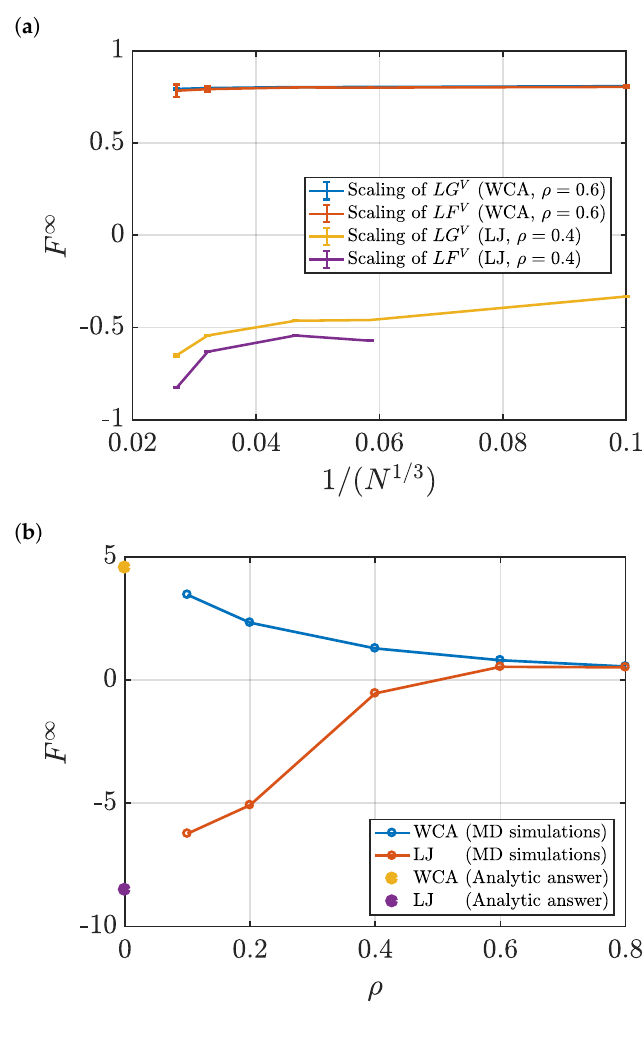
Figure 14. ( a ) Surface term in the thermodynamic limit F ∞ as a function of the size of the system for the WCA fluid at ρ = 0.6, and the LJ fluid at ρ = 0.4. Both fluids are simulated at T = 2 (dimensionless units). ( b ) F ∞ as a function of dimensionless density ρ of LJ and WCA systems at T = 2. For all densities, the same number of particles is used, N =